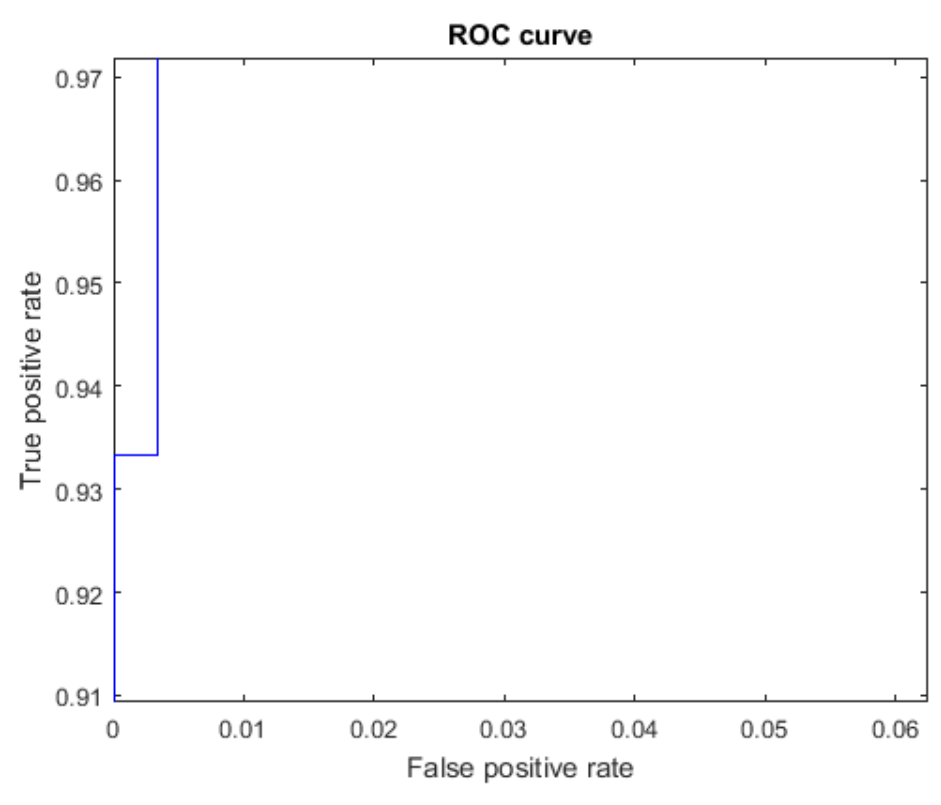
Figure 16. ROC curve for the letter R using Cartesian features, AUC = 0.9998.